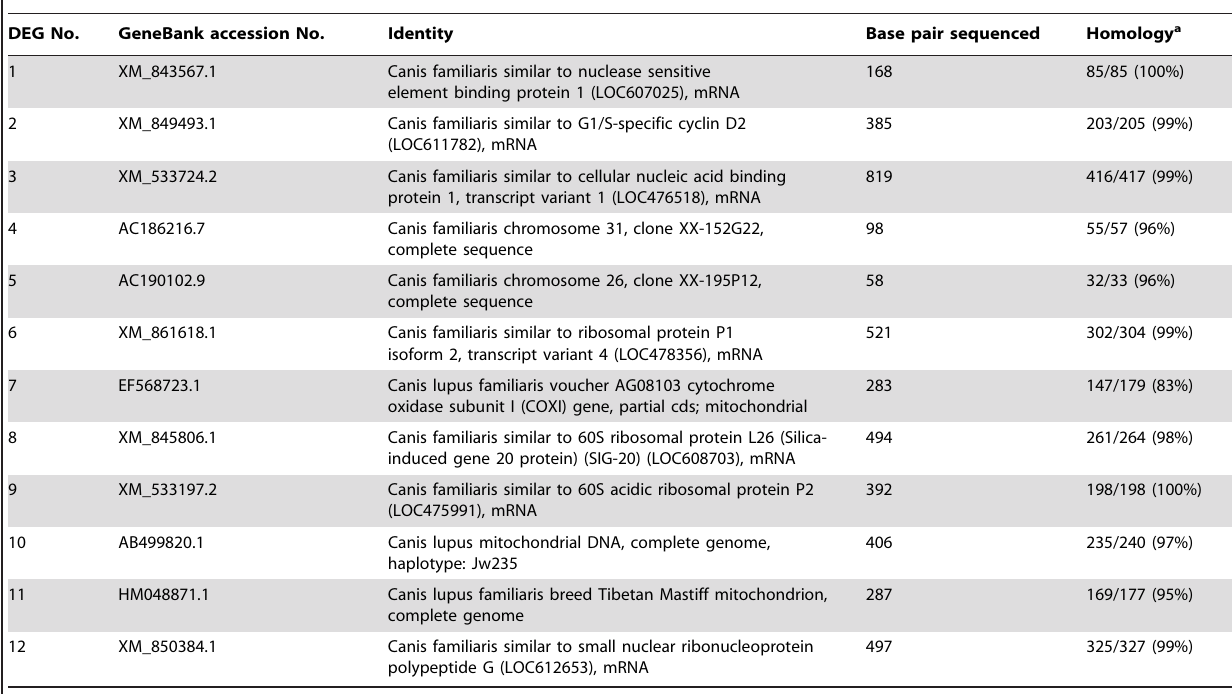
Table 4. Identity of DEG sequences by BLAST searches.